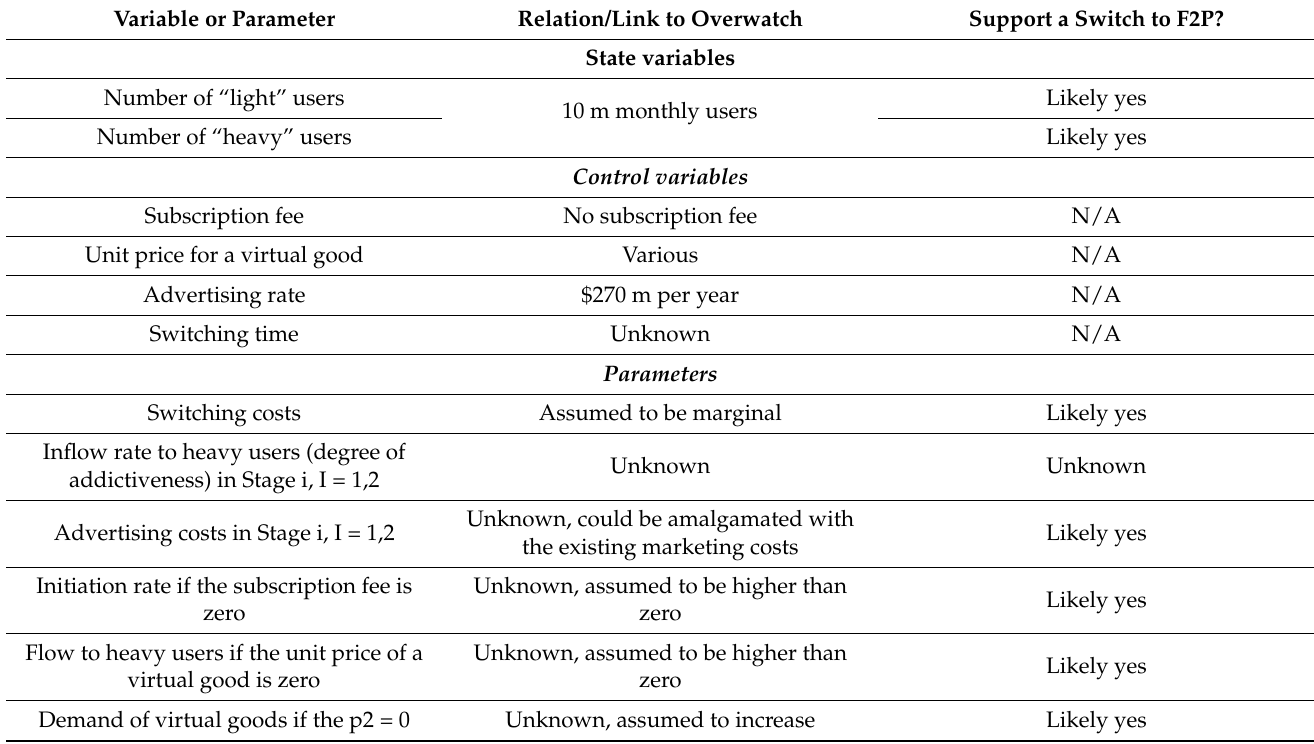
Table 3. Application of Seidl et al. (2018) to